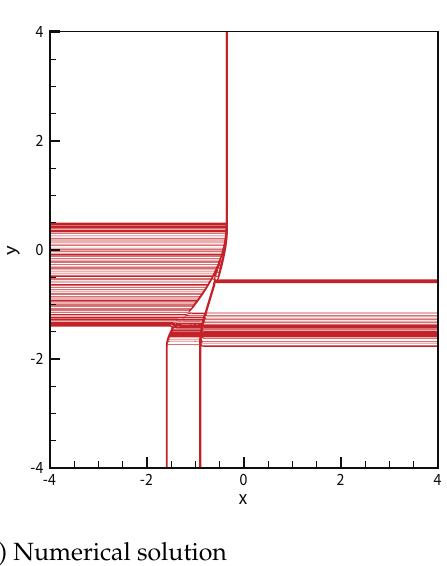
Figure 13. Case 13. S δ + R + SJ + RJ